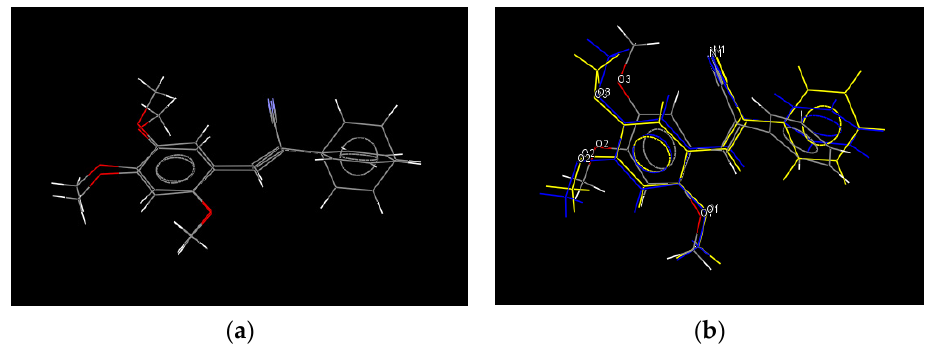
Figure 12. Overlay of the molecule structures of crystal Ia, Ib and Ic . ( a ) Overlay Ia and Ic and ( b ) overlary of Ia , Ib and